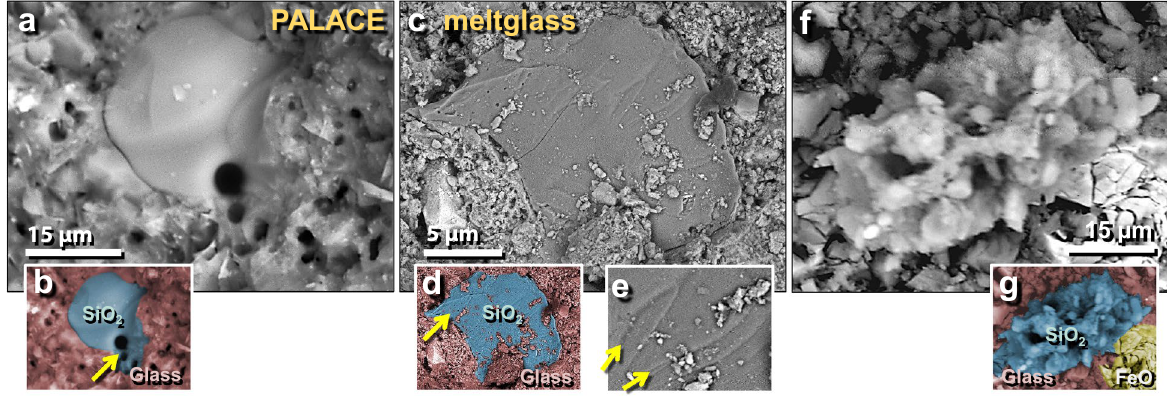
Figure 23. SEM images of melted quartz grains on melted mudbrick from the palace. ( a ) Highly melted quartz grain; ( b ) manually constructed EDS-based phase map indicates center is pure SiO 2 surrounded by melted mudbrick. Arrow points to vesicles indicating outgassing as grain temperature rose above ~ 1713 °C, the melting point of quartz. ( c ) The surface of a flattened quartz grain showing flow marks toward the upper right. High temperatures are required to lower the viscosity sufficiently for quartz to flow. ( d ) Manually constructed EDS-based phase map with an arrow pointing to vesicles indicating outgassing at high temperatures. ( e ) Close up of grain in panel ‘ c ’ showing flow marks (schlieren) at arrows. ( f ) Shattered, melted quartz splattered onto mudbrick meltglass; ( g ) manually constructed EDS-based phase map indicating that the blue area is SiO 2 ; the yellow area is a shattered, thermally altered Fe-oxide